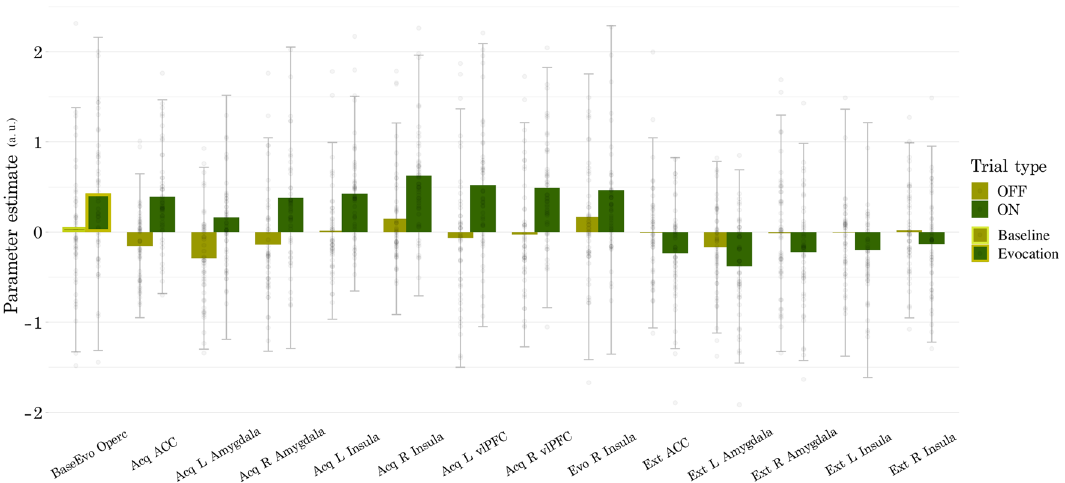
Figure 6. Parameter estimates are plotted for all clusters and contrasts. Raw parameter estimates were extracted using MarsBar in SPM, with no scaling applied. Parameter estimates represent the mean beta value of the entire ROI, as derived from the Harvard Oxford cortical and subcortical structures atlases. The first two, highlighted bars represent the contrast between baseline high pain stimulations and evocation phase nocebo trials when pain was augmented by the nocebo manipulation. The remaining bars represent the contrast between nocebo and control trials for each of the experimental